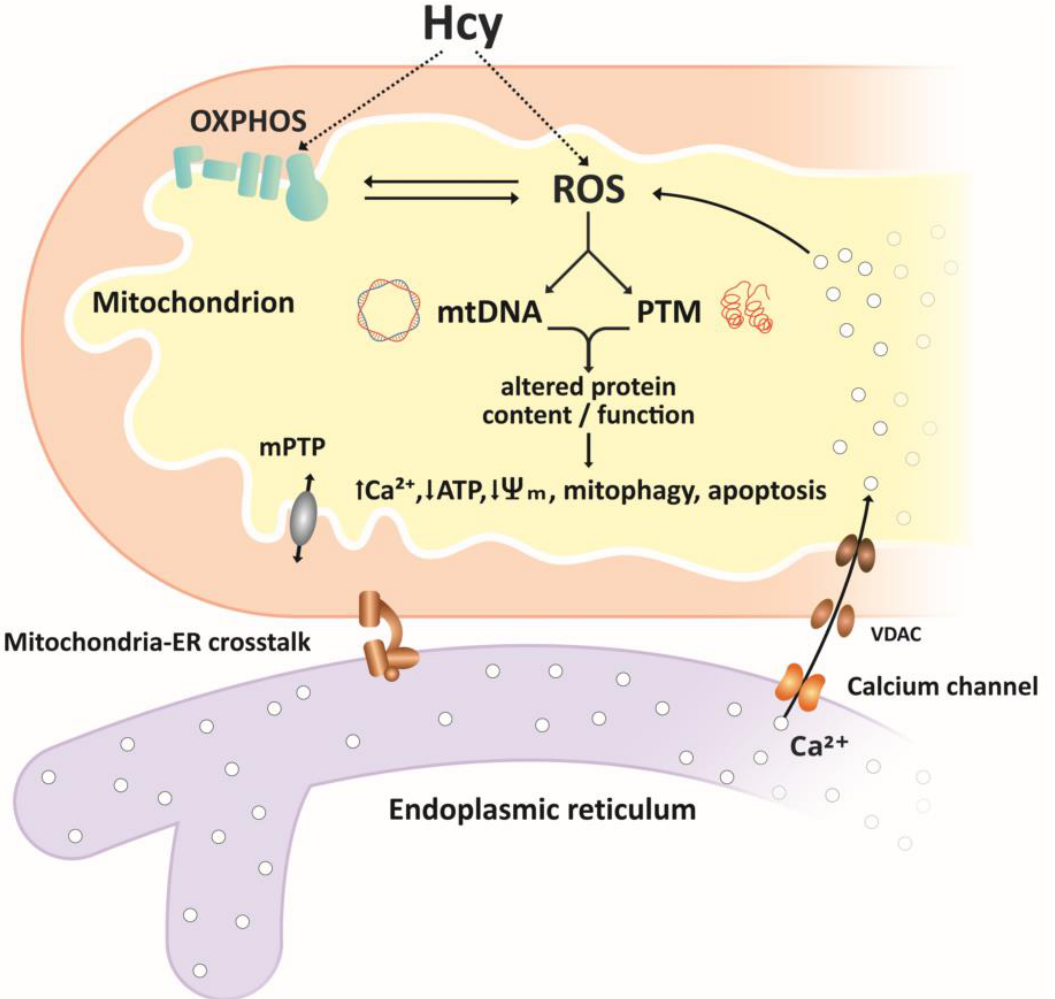
Figure 2. Simplified overview of homocysteine effects on mitochondria. Reactive oxygen species ROS, produced in the electron transport chain ETC or through autooxidation of Hcy, are important mediators of Hcy effects on mitochondrial function. ROS-associated oxidative damage to mtDNA and post-translational modifications PTMs of proteins result in altered content and/or function of mitochondrial proteins, including components of the ETC, antioxidant/pro-oxidant enzymes, membrane carriers, and receptors. Altered function of mitochondrial proteins may result in further increases in ROS levels, accumulation of Ca 2+ ions mediated by mitochondria–ER crosstalk, decrease in ATP production, decreased membrane potential, and initiation of mitophagy and apoptosis.